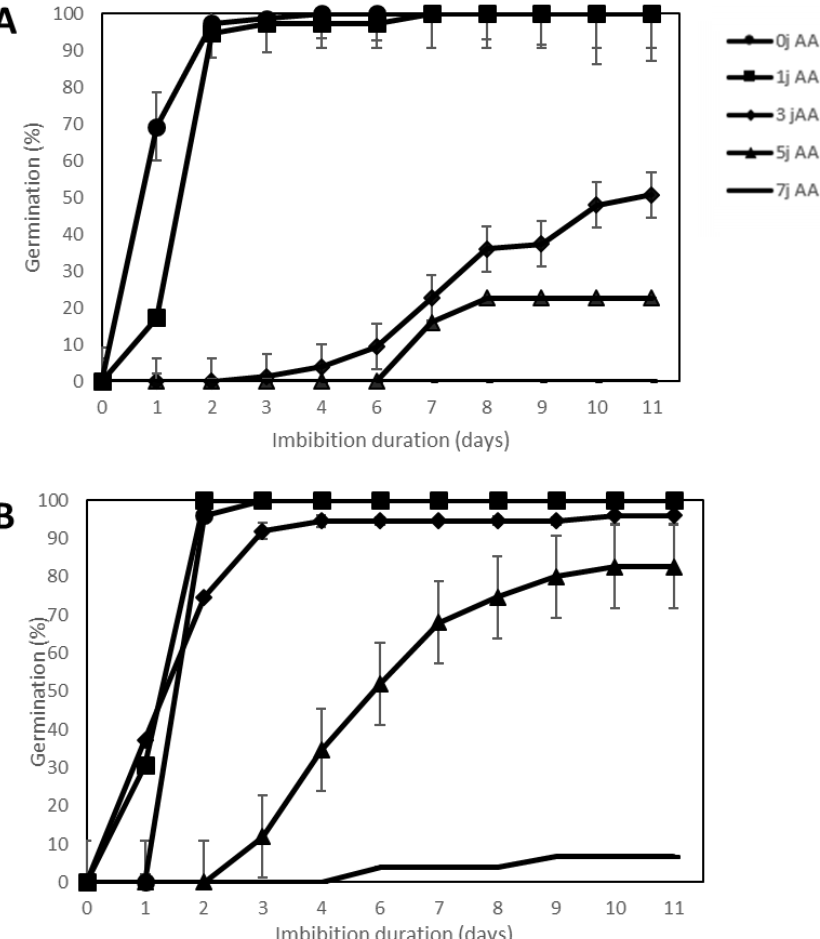
Figure 3. Germination curves of 2 sunflower genotypes, Helianthus annuus sp. SOLQUA-160 ( A ) and SOLQUA-165 ( B ) Accelerated ageing (AA) was applied for 1, 3, 4 or 7 days (as compared to the control 0, which corresponded to non-aged seeds); germination tests were then performed on water at 20 °C.